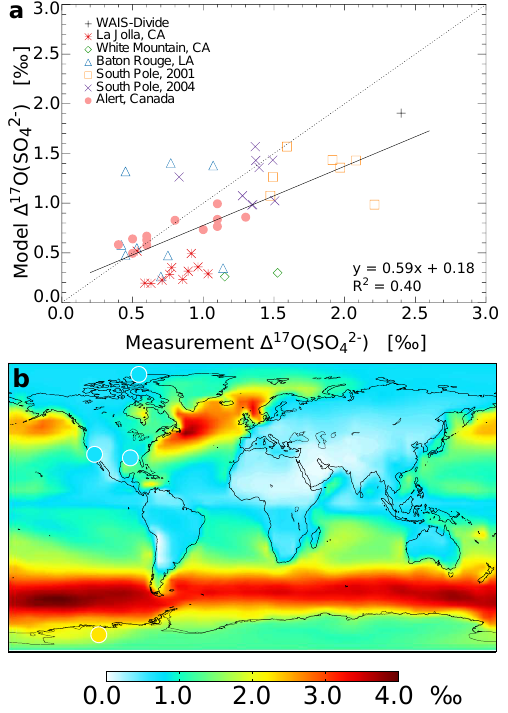
) at the surface to 4 ) observa- 4 ) 4